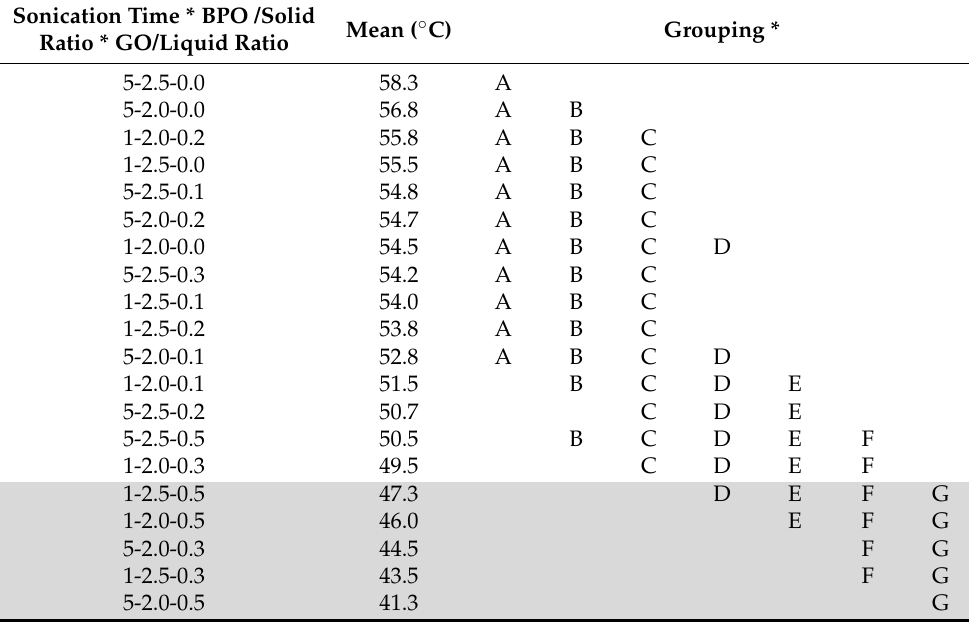
Table 2. Grouping information for T max using Tukey’s test and 95%